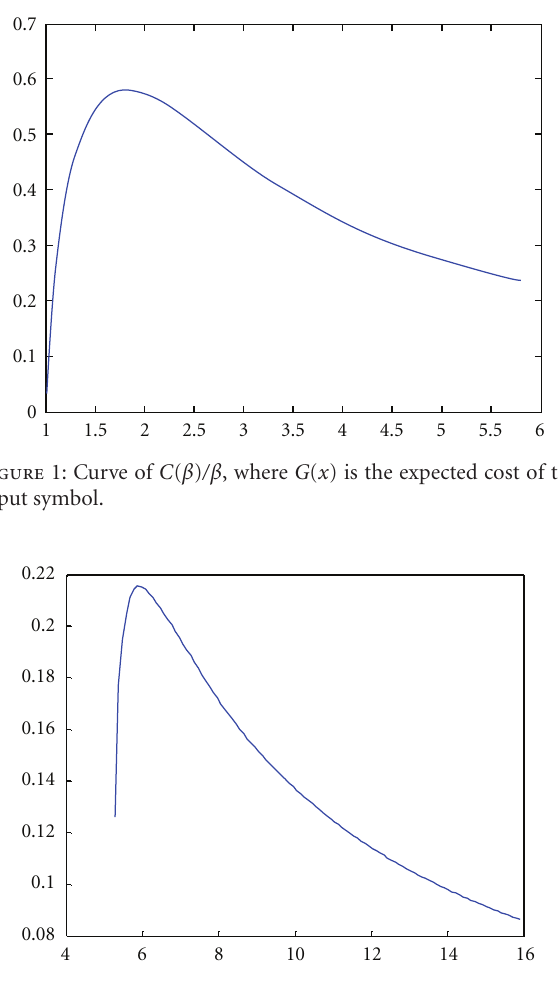
Figure 2: Curve of C ( β ) /β , where G ( x ) is a positive definite quadratic